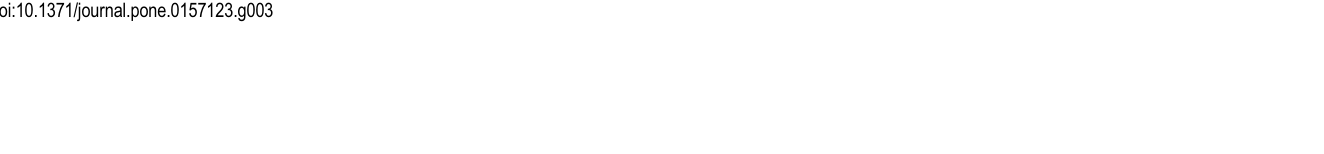
PLOS ONE | DOI:10.1371/journal.pone.0157123 June 13,